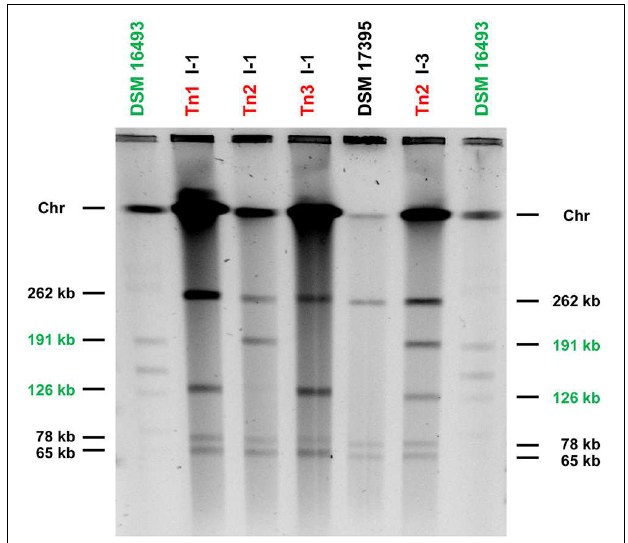
FIGURE 2 | Plasmid profiles of the P. inhibens DSM 17395 tranconjugants Tn1 (I-1), Tn2 (I-1), Tn3 (I-1), and Tn2 (I-3) obtained by pulsed-field gel electrophoresis (PFGE). The PFGE conditions for separation of the high molecular weight genomic DNA were as follows: 1.0% (w/v) agarose gel with pulse times of 1–40 s for 25 h at 200 V (6 V/cm). Conjugative plasmids of the donor strain D. shibae DSM 16493 T are highlighted in green. The completely sequenced wild-type strains served as references and size standards. Chr, chromosomal DNA.